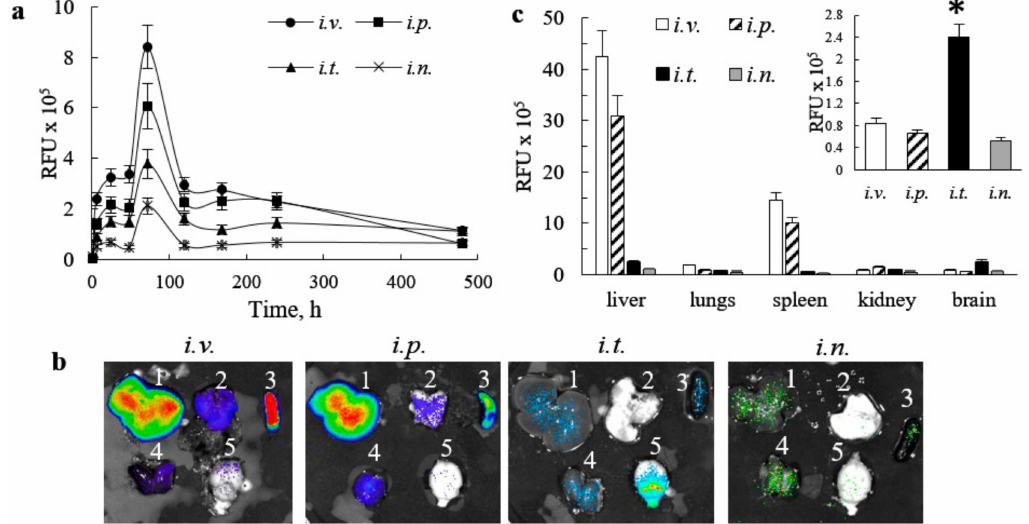
Figure 2. Quantification of DIR-EVs distribution ( a ) in the brain in live animals at various points, and ( b,c ) necroscopy at 480 h in the whole organs in CLN2 Batten disease (BD) mice by IVIS. The groups of four animals BD mice were injected with DIR-EVs, as described in Figure 1. ( a ) The greatest DIR-EVs signals were detected in BD mouse brain after i.v ., and i.p . injections at 72 h. ( b ) At the endpoint (480 h), mice were sacrificed, perfused, and main organs (i.e., liver (1), lungs (2), spleen (3), kidney (4), and brain (5)) were imaged by IVIS, and (c) quantification of DIR-EVs signals in the organs of BD mice was assessed by IVIS Aura software. The highest DIR-EVs signals were recorded in liver, and spleen in mice after i.v. and i.p. injections. The amount of EVs carriers in the brain of BD injected through i.t. route was significantly greater compared to all other injections (insert). Values are the means ± SEM, N = 4, * p <